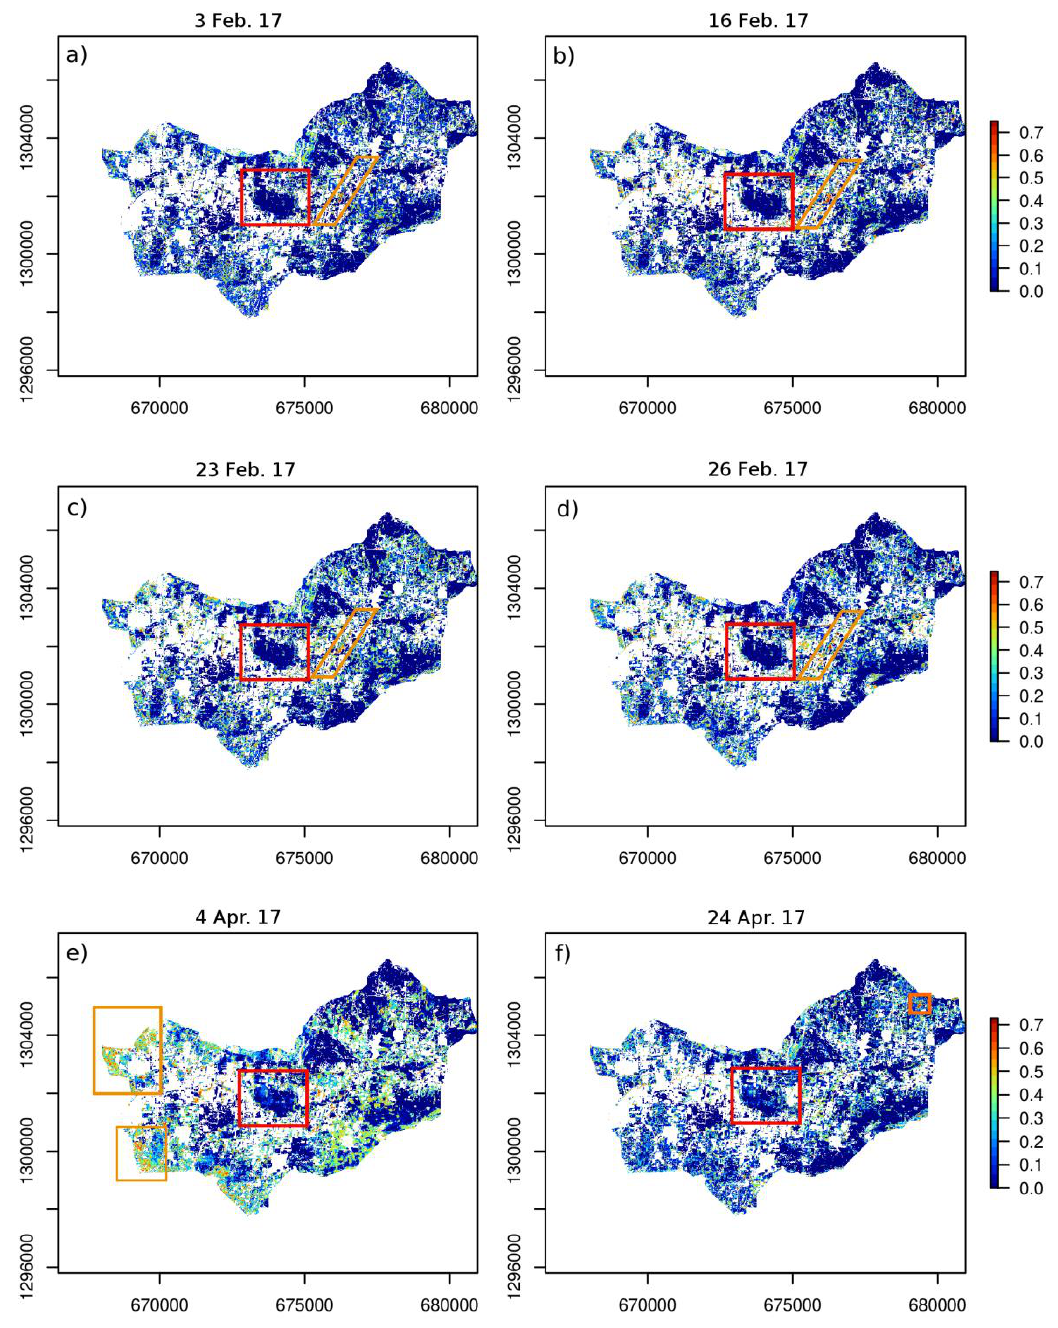
Figure 7. Maps of the Simpson’s diversity index obtained from the image acquired on ( a ) 3 Feb. 2017, ( b ) 16 Feb. 2017, ( c ) 23 Feb. 2017, ( d ) 26 Feb. 2017, ( e ) 4 Apr. 2017 and ( f ) 24 Apr. 2017. The white areas correspond to the masked mixed